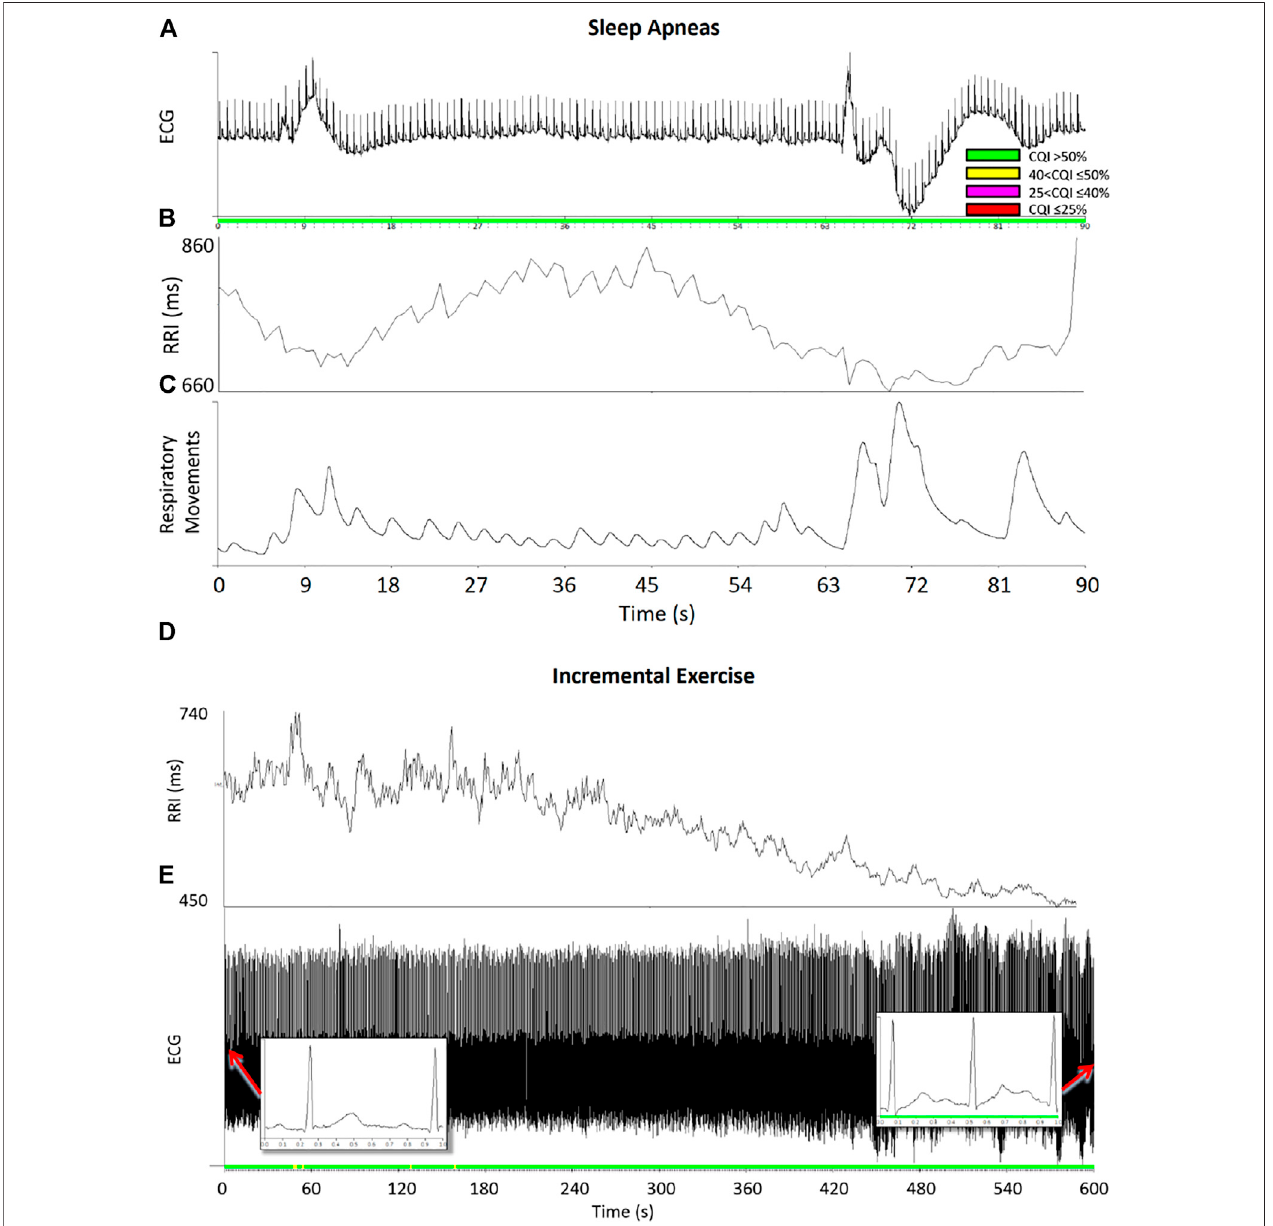
FIGURE 9 | Examples of running cepstral during ramp-like heart-rate changes. Upper panels: ECG (A) , R-R intervals, RRI (B) , and respiratory movements of the thorax (C) duringsleepapneas;colorcodesrepresenttheCQIlevels.Evenifapnea/deepbreathingeventsproducedlargeramp-likechangesofheartrate,theCQIscore remained relatively high classifying the data segment ofgood quality for heart rate variability analysis. Lower panels: R-R intervals (D) and ECG (E) during an incremental exercise test on the cycloergometer: the ECG was in normal sinus rhythm (see insets) and the CQI score remained high even when RRI progressively decreased during the